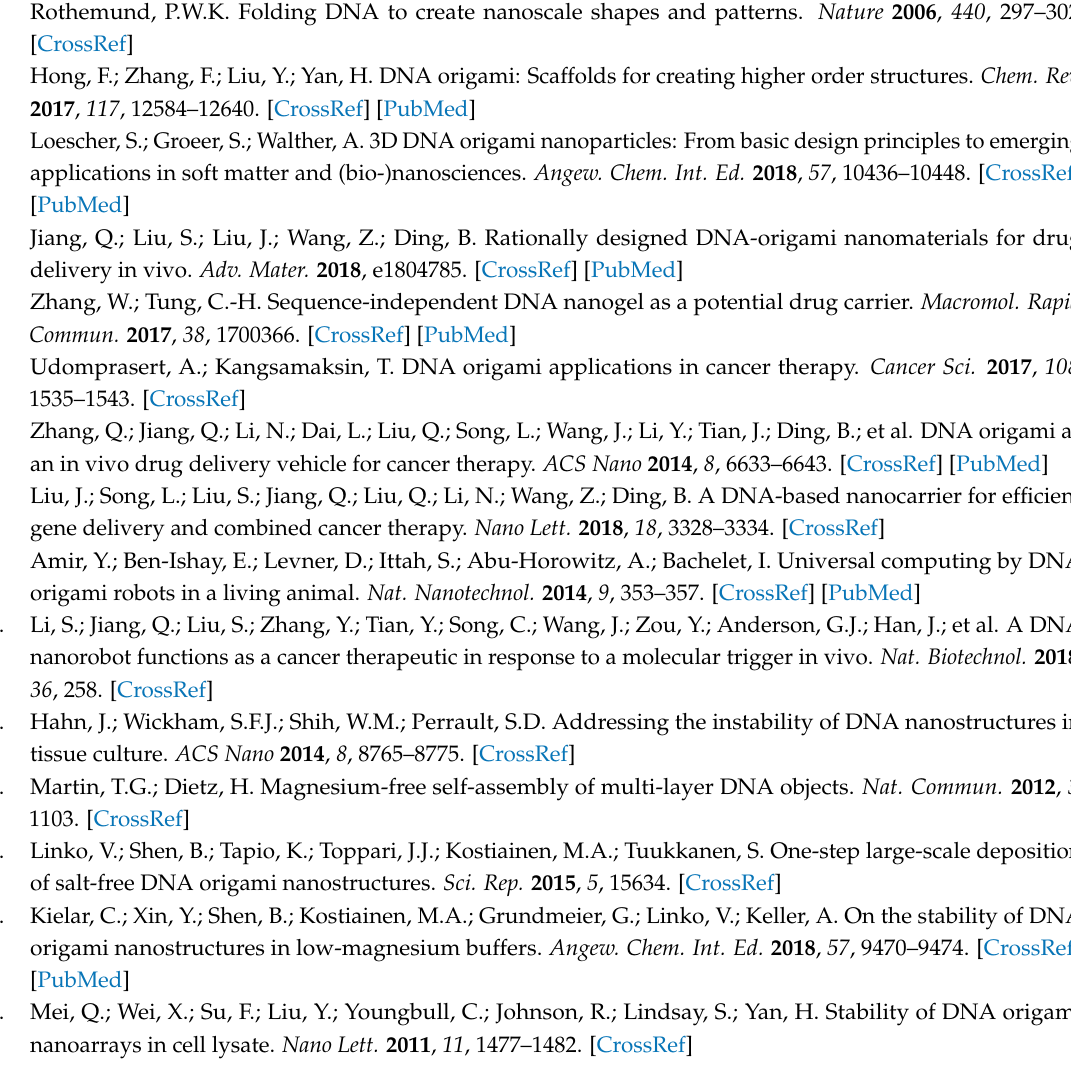
Orig2 and Orig3 . Figure S15: TEM imaging of the coated Orig1 in buffer for two days. Figure S16: TEM images and Gel EMSA of complexes of avidin and Orig1 . Figure S17: Gel EMSA of HSA and Orig1 complexes. Figure S18: TEM images of coated Orig2 and Orig3 treated with DNase I. Figure S19: Gel EMSA of coated Orig1 with low ratios treated with DNase I. Figure S20: TEM images of coated Orig1 with ratio 4000 under DNase I treatment, low salt, weak acid conditions. Figure S21: TEM images of coated Orig1 with ratio 1000 under low salt, weak acid conditions. Figure S22: TEM images of coated Orig1 with different ratios in cell medium. Figure S23: Relative red fluorescence data in cells of plain origami and coated origami samples. Figure S24: Cytotoxicity assay for pure Orig1 , coated Orig1 and free cHSA. Figure S25: Cadnano map of Orig1 , Orig2 and Orig3 . Table S1: Strands for DNA